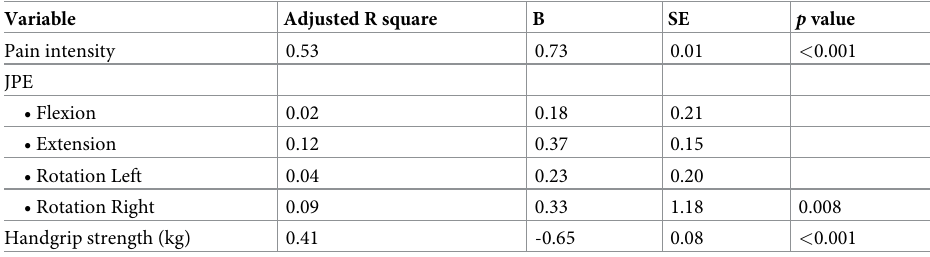
JPE = joint position error; B = Standardized Coefficients Beta, SE = standard